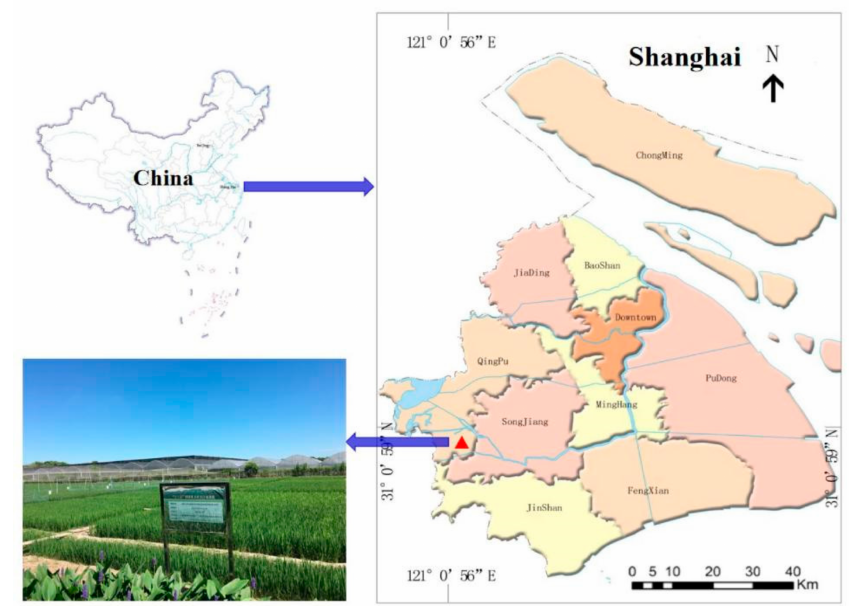
Figure 1. Location of the field experimental